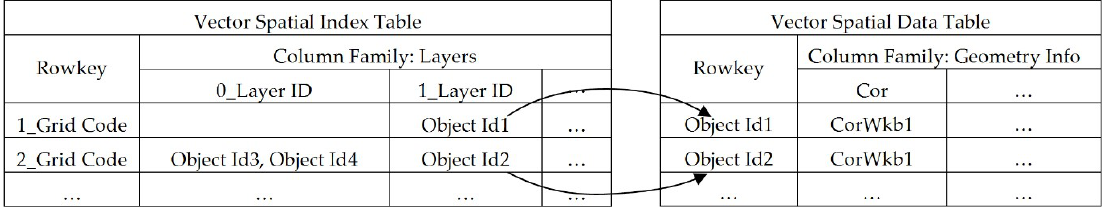
Figure 10. Flowchart of the index parallel construction based on MapReduce.